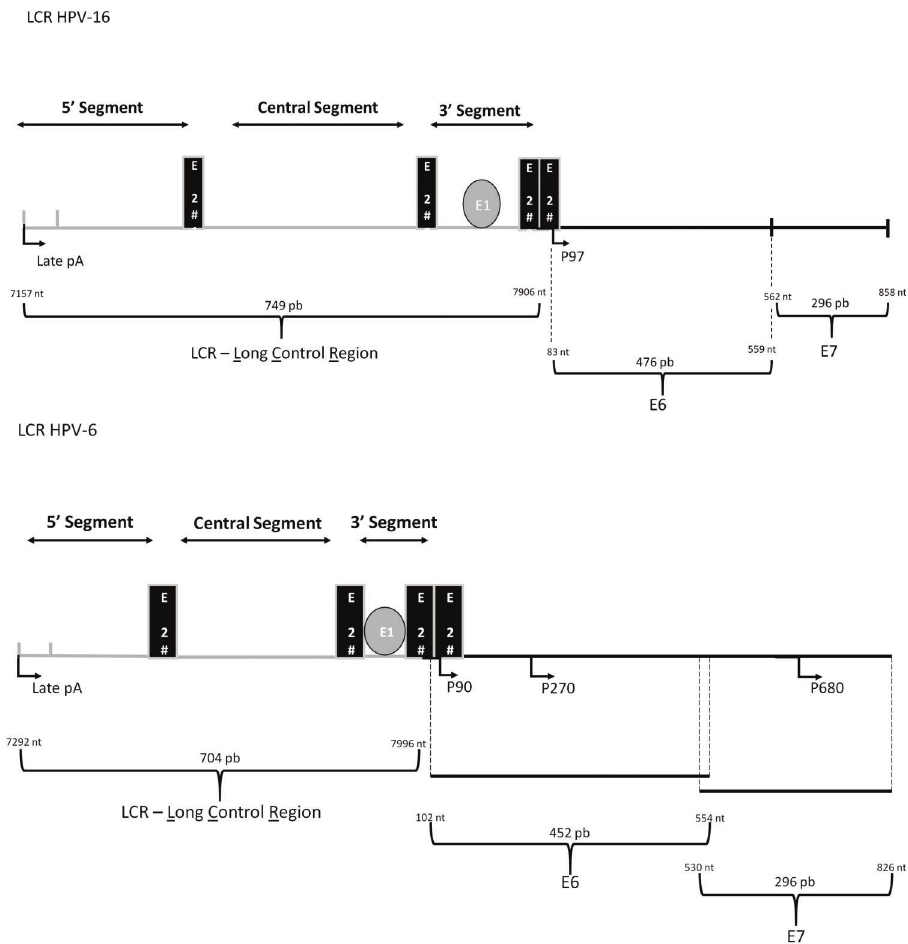
Figure 1 - Schematic representation of the LCR and E6 and E7 genes from high- and low-risk HPVs, represented by HPV-16 and HPV-6, respectively. Four E2 binding sites (E2bs) are conserved among mucosal HPVs, with E2bs#1 and E2bs#2 dividing the LCR in three distinct segments: the 5 ’ segment, the central segment and the 3 ’ segment. The 5 ’ segment contains the late transcription termination signal, denominated ‘ late pA ’ , the central segment functions as an epithelial-specific enhancer, and the 3 ’ segment encloses the ori region. Early promoters are also indicated: HPV-16 (P97) and HPV-6 (P90, P270,